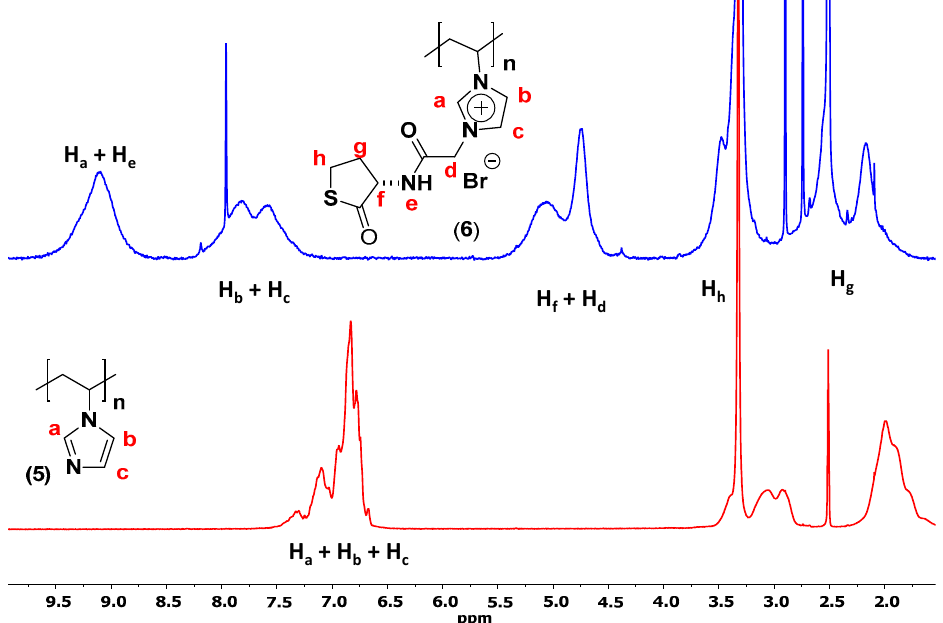
Figure 3. 1 H-NMR (D 2 O) spectra of 5 (poly(1-vinylimidazolium bromide)) and 6 (3-acetamide- dl -homocysteine thiolactone-1-vinylimidazolium bromide).